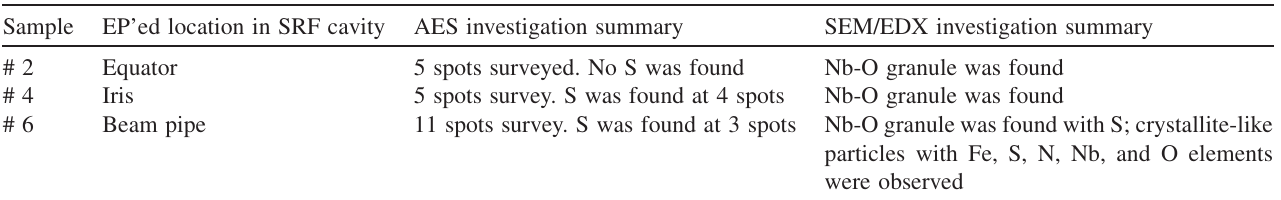
TABLE II. Summary of the three samples investigated by AES and SEM/EDX